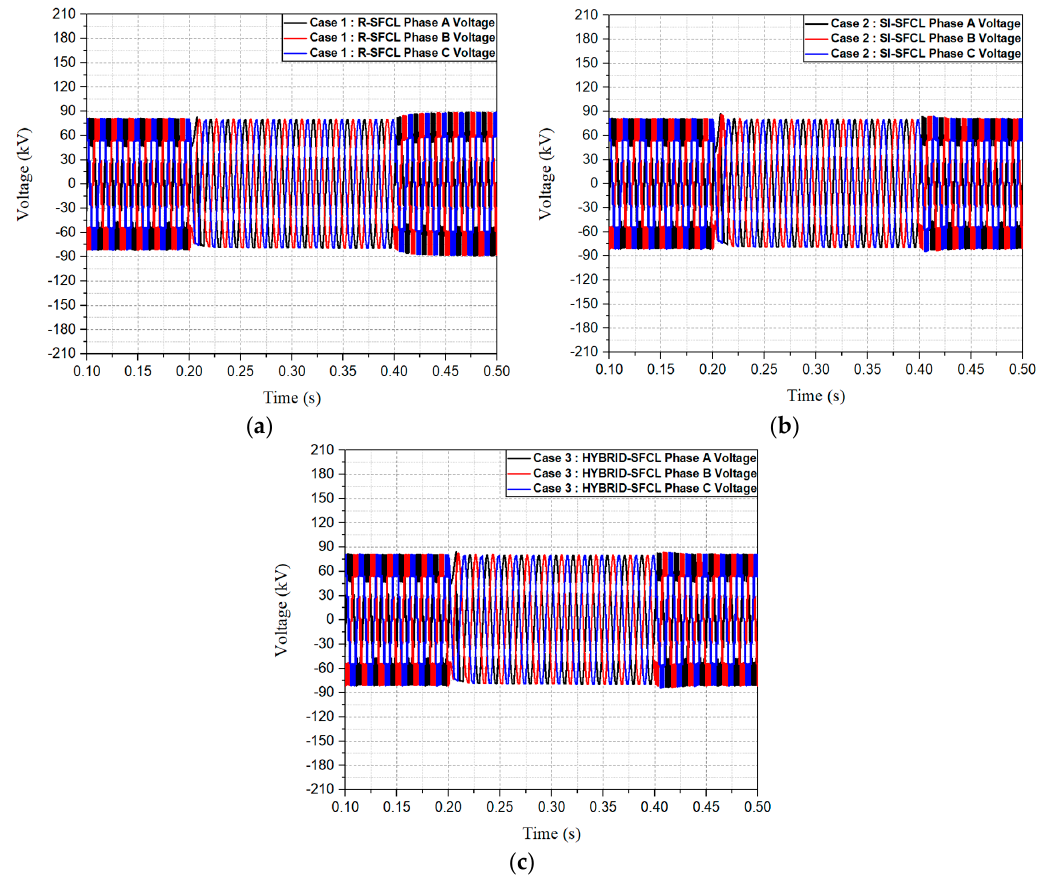
Figure 17. The transient voltage waveforms of the AC system according to the protection scheme: ( a ) Case 1: Protection scheme (R-SFCL and HCB); ( b ) Case 2: Protection scheme (SI-SFCL and HCB); ( c ) Case 3: Protection scheme (Hybrid-SFCL and HCB).